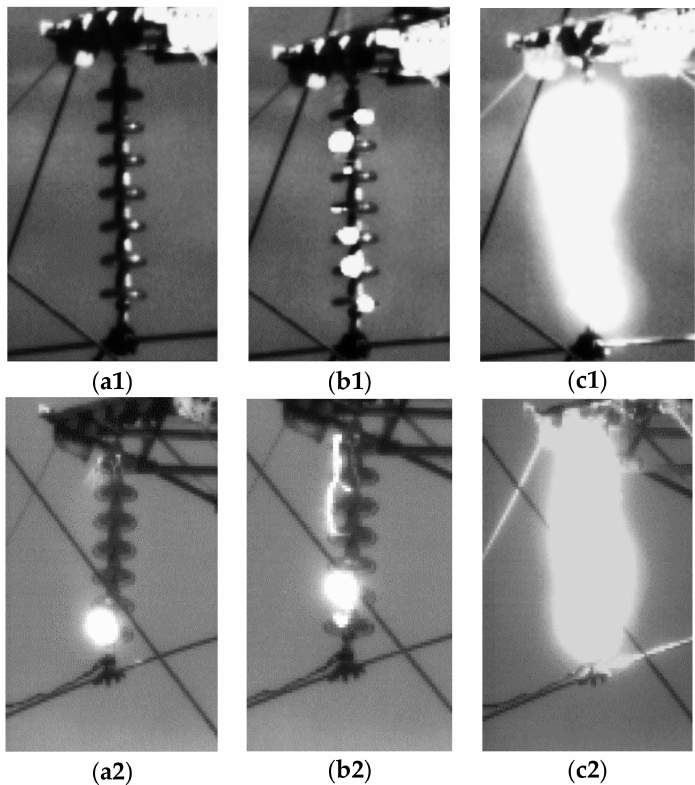
Figure 4. The two typical flashover processes of glass insulator. One typical process is ( a1 , b1 , c1 ); the other is ( a2 , b2 , c2 ). ( a1 , a2 , b1 , b2 ) are the process of leader development; ( c1 , c2 ) have formed the entire arc channel.